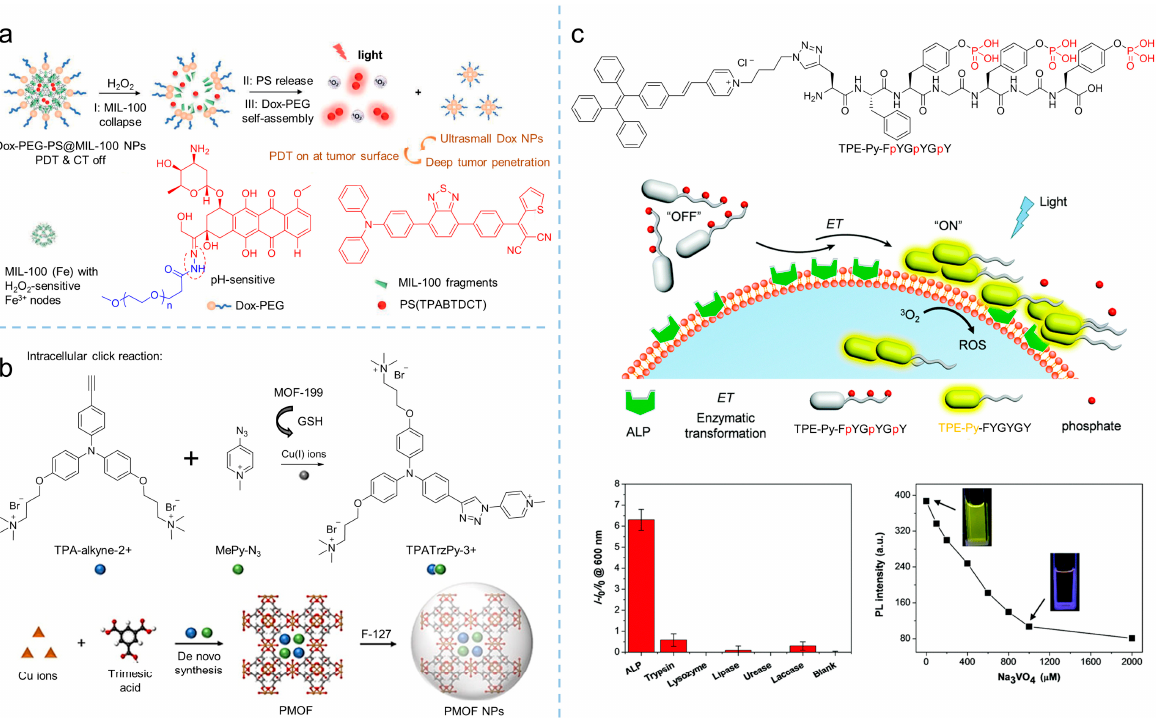
Figure 15. Activatable photosensitizers to enhance theranostics. ( a ) Schemes of MIL-100 collapse,